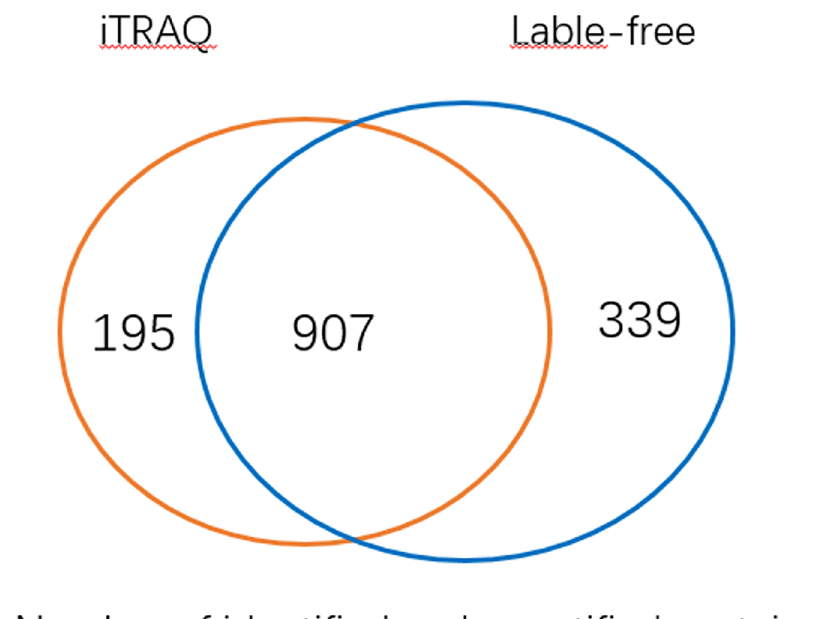
Fig 1. Comparison of results obtained from iTRAQ and label free-based analysis. Number of proteins identifiedin iTRAQ or label free-basedanalysis.